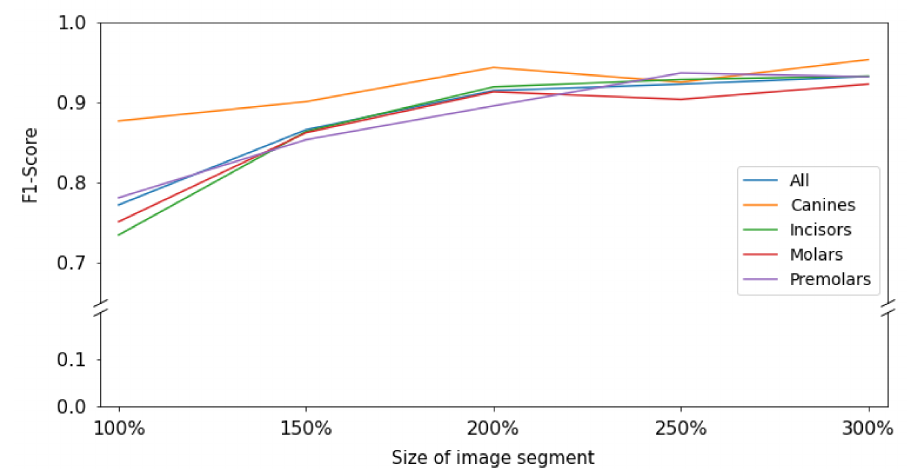
Figure 3. Visualization of F1-score for the test set for each image context size grouped per tooth group and over all tooth groups. The baseline size of 100% captured image segments with the size of the annotation bounding box; the image segment size of 300% covered image segments with the size of the bounding box upscaled by a factor of 3.